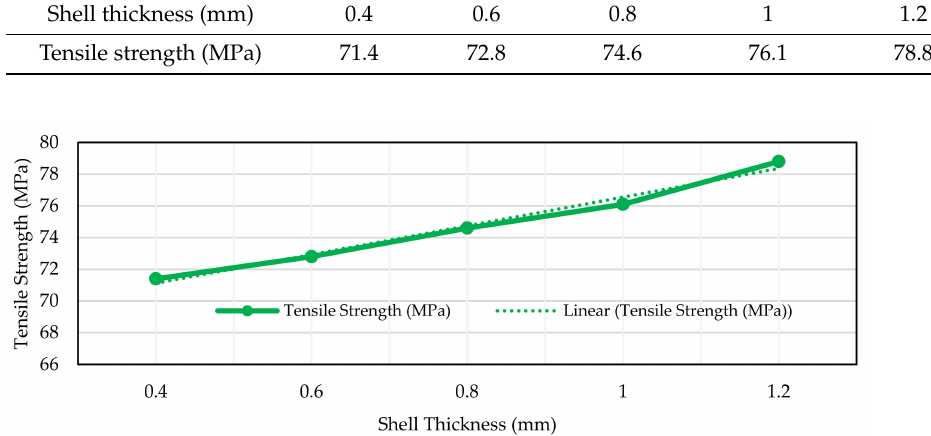
Figure 11. Tensile strength vs. shell